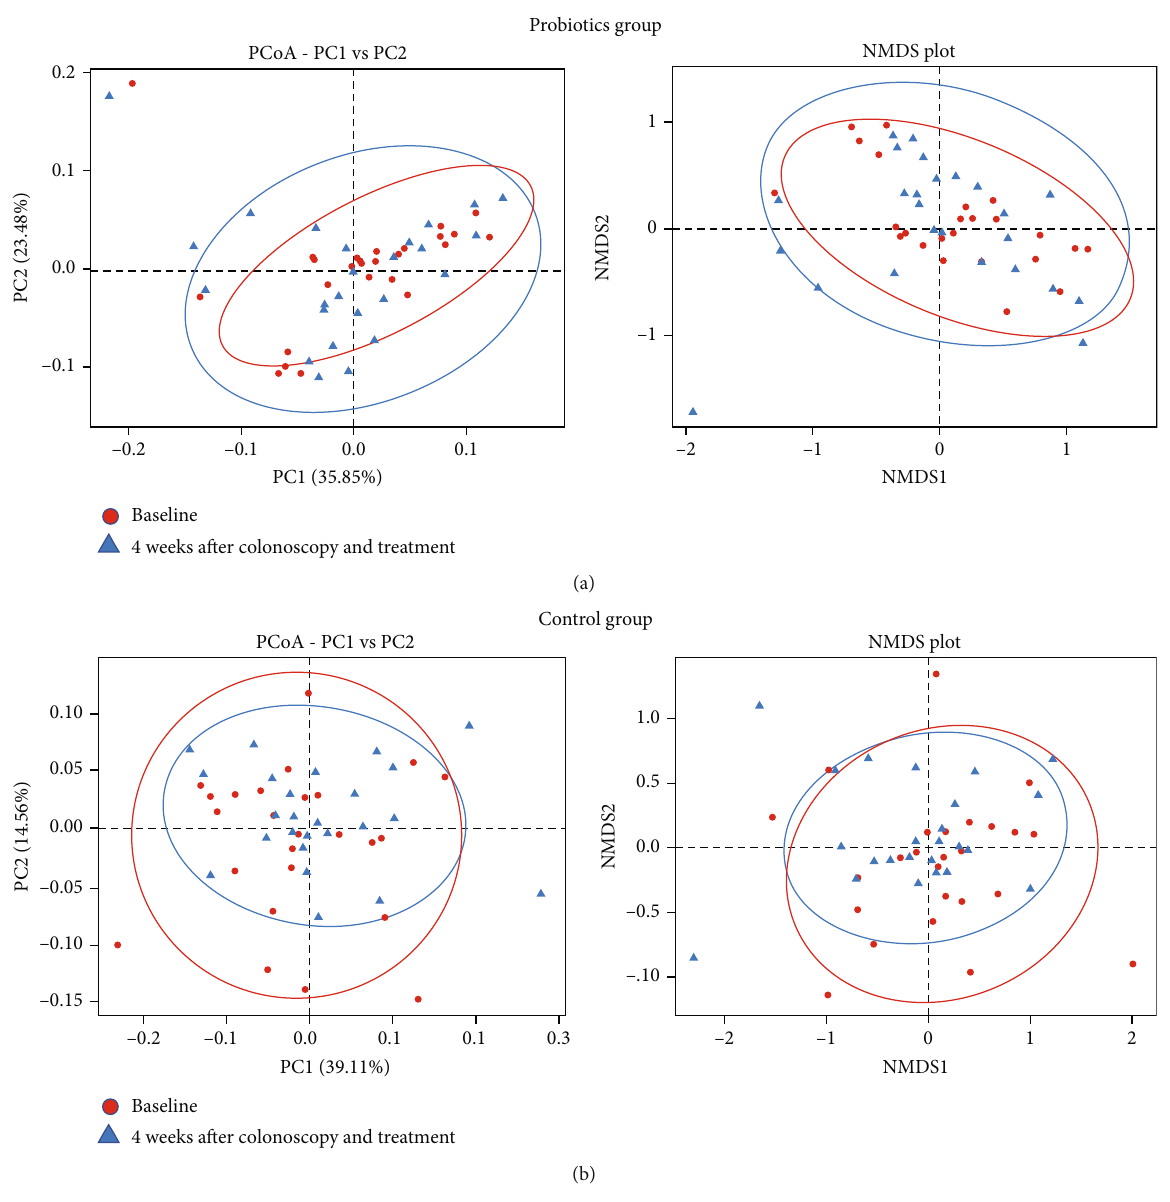
Figure 5: Di ff erences in microbiota composition ( β -diversity) in the probiotics group (a) and control group (b). Principal coordinate analysis (PCoA) and nonmetric multidimensional scaling (NMDS) analysis between the baseline and 4 weeks after colonoscopy and treatment. The β -diversity 4 weeks after colonoscopy and treatment of the probiotics group were more divergent than those in the baseline. However, the β -diversity 4 weeks after colonoscopy and treatment of the control group were less divergent than those in the baseline. PC1: principal coordinate 1; PC2: principal coordinate